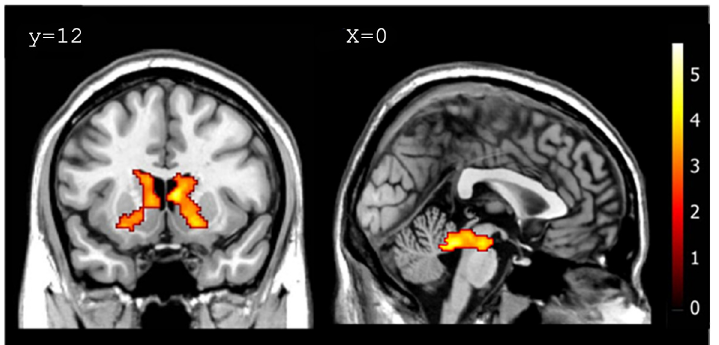
Fig 4. Areas in the striatum and midbrain positively correlated with the winning rate (obtained from the parametric analyses in the first GLM). Activities in the striatum (Left; caudate nucleus and putamen) and midbrain (Right) were significantly correlated with the winning rate in each block. Within the striatal ROIs, the statistical threshold was set at p < 0.005 (uncorrected) and cluster p < 0.05